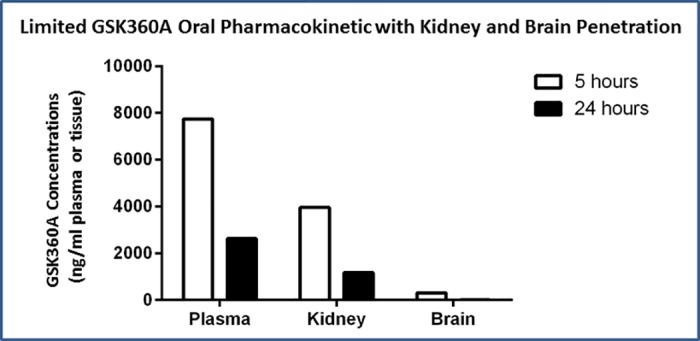
The blood plasma, kidney, and brain concentration levels (ng/ml) of GSK360A presented for 5 and 24 hours after GSK360A (30 mg/kg) was administered orally by gavage.Adequate plasma and peripheral end-organ levels were achieved as also cross-validated by our previous plasma data (37). N = 2 rats per measurement; corroborated by previous data [37].